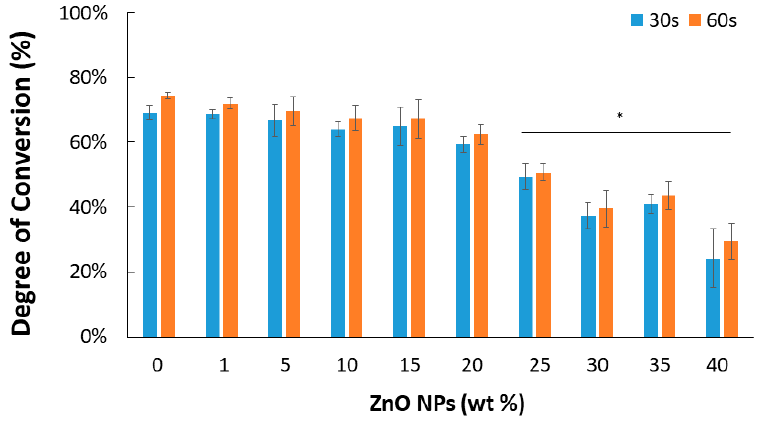
Figure 1. The degree of conversion (DC) for the methacrylate-based resin blends. * Indicates a sta- tistically significant decrease from the control resin blend (0 wt% ZnO NPs) (* p < 0.05; n = 3).